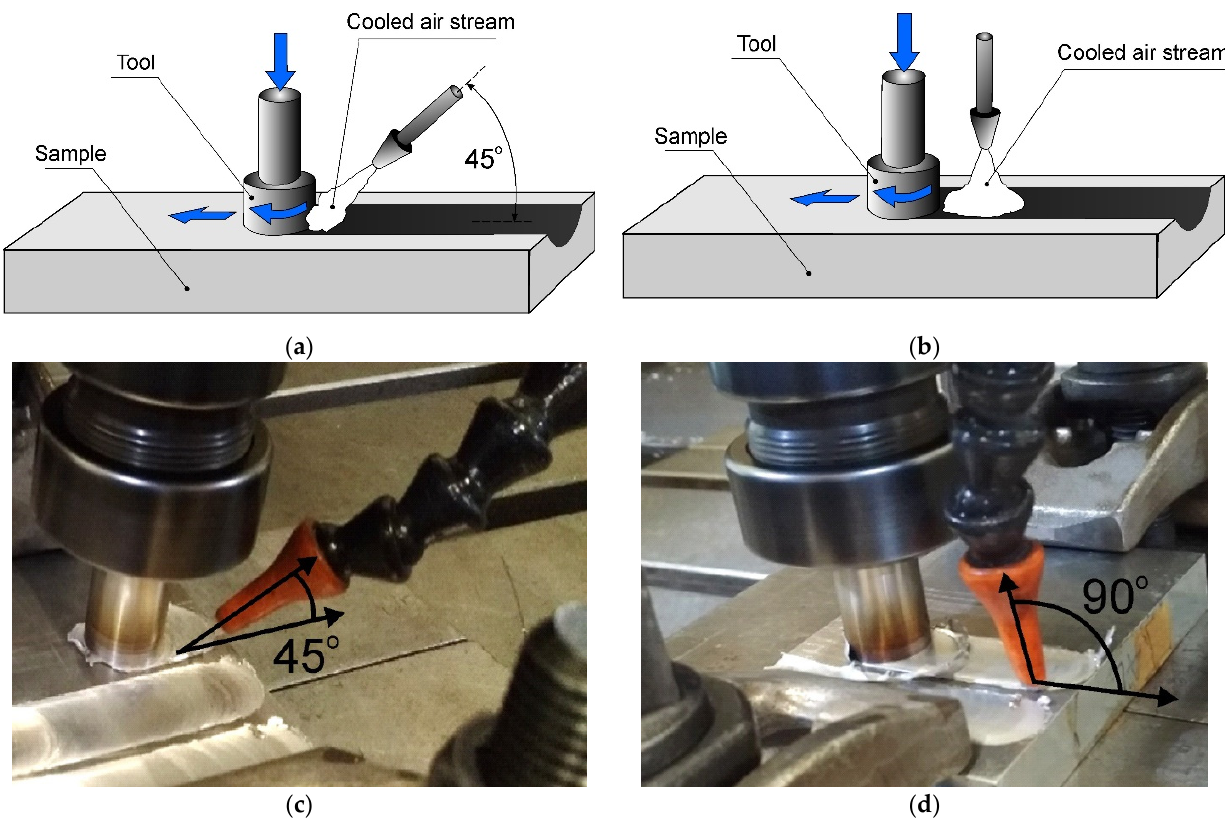
Figure 3. Schemes of FSP variants ( a , b ), photos of stands ( c , d ). Table 2. Processing parameters of 7075 aluminum alloy.